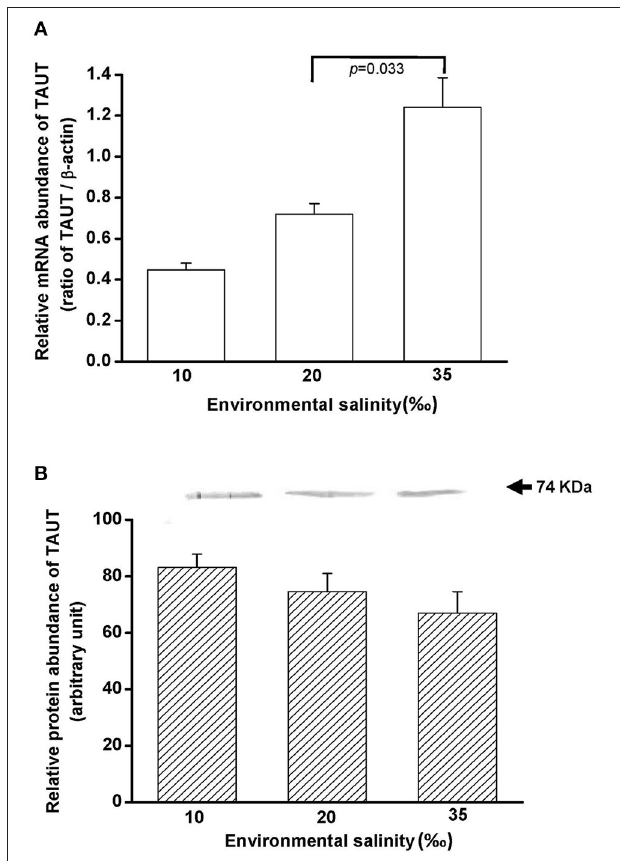
FIGURE 8 | Salinity effects on TAUT mRNA (A) and protein expression (B) in mantles of the hard clam. The representative immunoblot for the protein expression was shown in (B) . Statistical analysis was performed with one-way ANOVA followed by Dunnett’s test. The 20 ‰ SW group was used as a control. p < 0.05 was considered statistically significant. Values are means ± SEM. ( N =